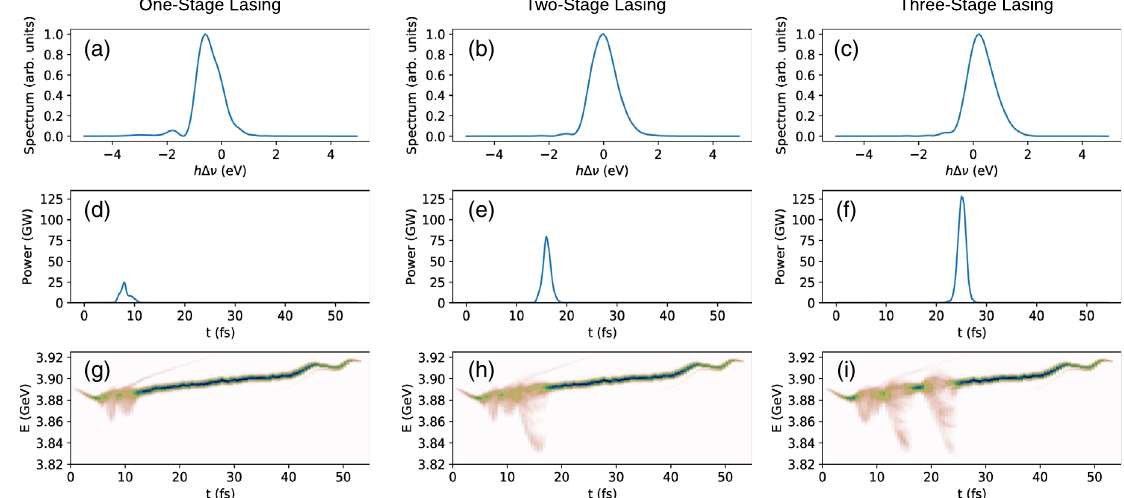
FIG. 10. (a) – (c) XFEL pulses in the frequency domain at the exit of the first, second, and third undulator sections. (d) – (f) XFEL pulses in the time domain at the exit of the first, second, and third undulator sections. (g) – (i) Phase space distributions of the electron bunch at the exit of the first, second, and third undulator